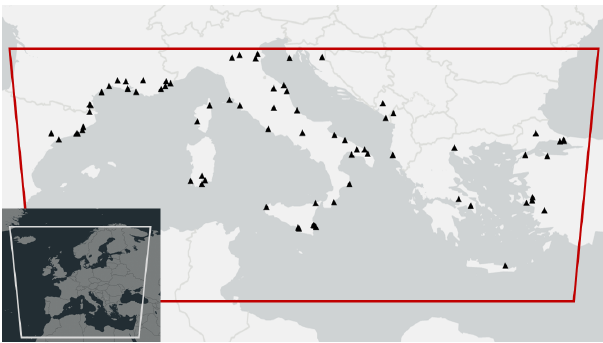
Figure 1. Domains and measurement stations. Red trapeze displays the 12km × 12km domain; black triangles are locations of mea- surement stations. At the bottom left, the larger 36km × 36km do- main is